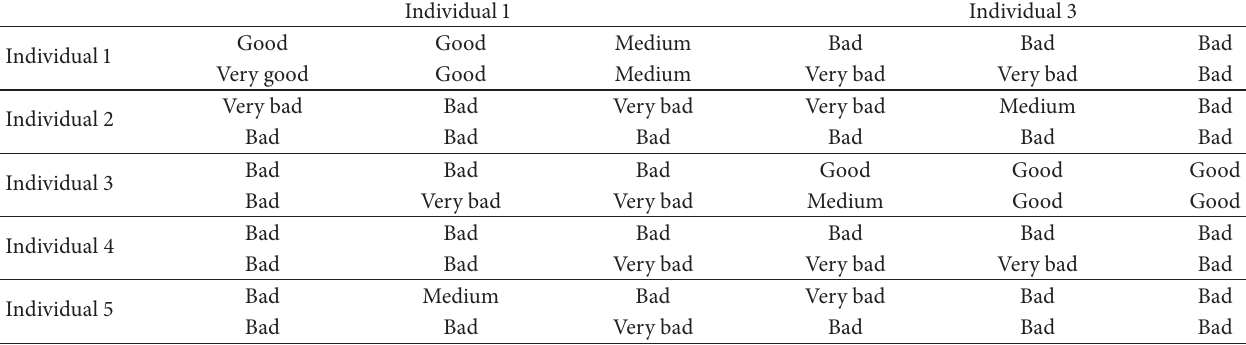
Table 7: Example of intraclass and interclass distributions using Experiment 6 (our proposed fuzzy matching fusion).